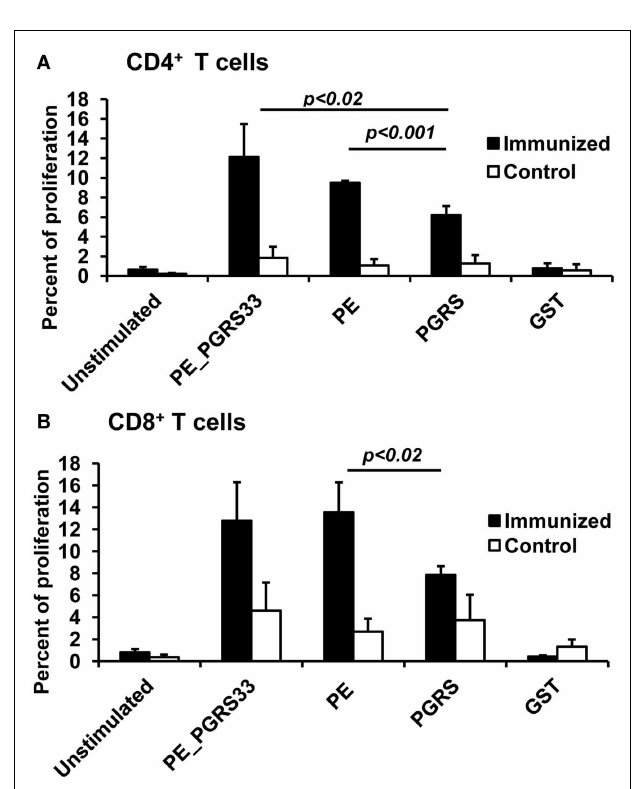
FIGURE 2 |Antigen-specific proliferation of CD4 + and CD8 + T cells in immunized mice. Splenocytes from PE_PGRS33-immunized mice were stained with CFSE and incubated with 25 µ g of PE_PGRS33, PGRS, PE, or GST protein plus 10 µ g of Polymyxin B for 4days. Spleen cells from mice injected with only nitrocellulose were also cultured with antigens (control). Cells without the antigens were incubated for the same length of time (unstimulated). Splenocytes were then labeled with anti-CD4-phycoerythrin (A) or anti-CD8-allophycocyanin (B) monoclonal antibodies and the percentage of proliferating cells were determined by CFSE dilution and flow cytometry. Each bar represents the mean ± SD of data from four mice per group, and the results are representative of those obtained from three independent experiments.